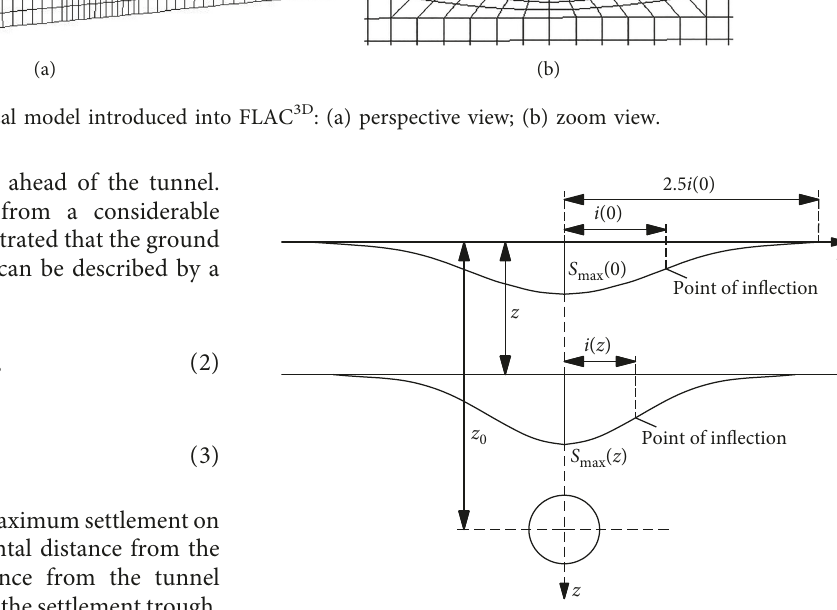
Figure 10: Definition of surface and subsurface settlement